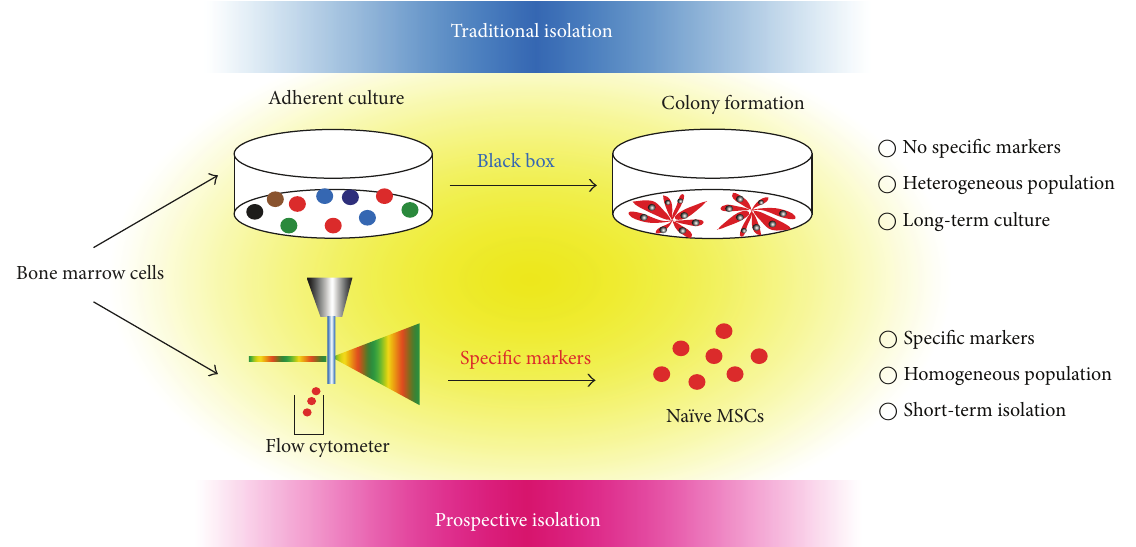
Figure 1: Prospective isolation of MSCs. Traditional MSC isolation by adherent culture on plastic tissue culture substrates (top). Following a period of prolonged culture, the majority of the contaminating cells are washed away or overgrown, enriching for CFU-Fs (colony formation). These MSCs have a spindle-shaped morphology and are capable of differentiating into adipocytes, chondrocytes, and osteoblasts in vitro . Prospective isolation of MSCs by using specific markers via flow cytometry (bottom). This method allows the isolation of a pure population of active, multipotent MSCs (na¨ıve MSCs) and avoids cellular